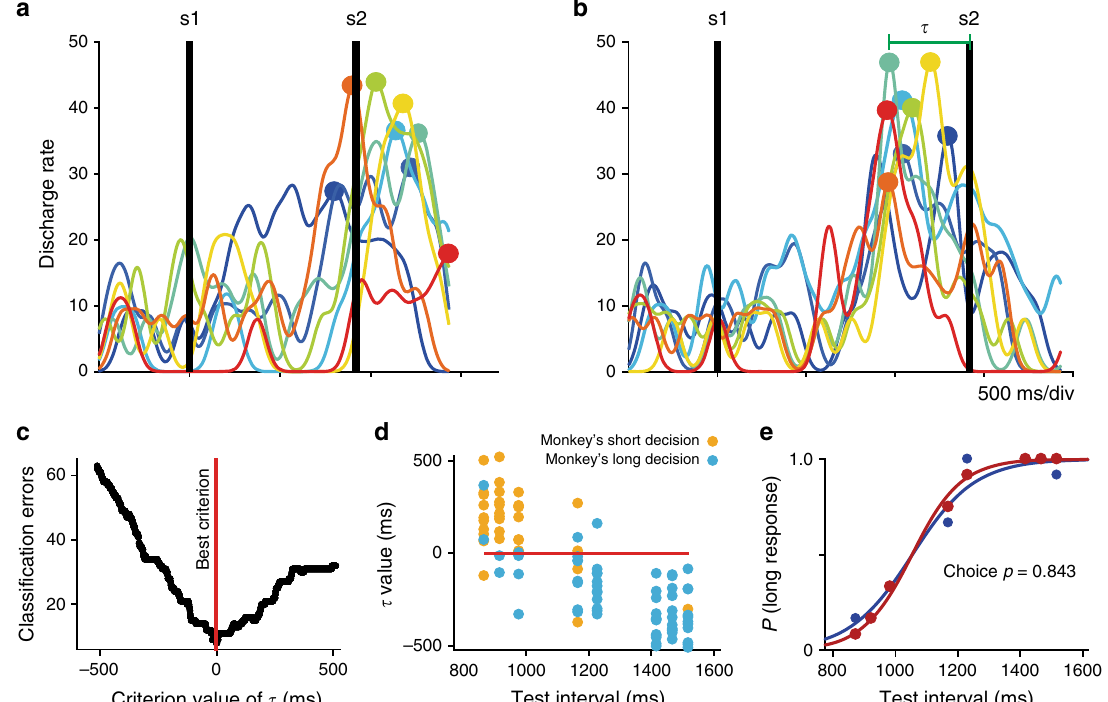
Fig. 4 Trial-by-trial decoding of the monkey ’ s forthcoming perceptual decision employing the peak activity time of boundary neurons. a SDFs of the boundary neuron in Fig. 2a, b for trials in which the shortest test interval (870 ms, block 3) was presented to the monkey. Each color line represents an individual trial (eight trials are shown). Dots indicate the moment of the peak activity. s1 and s2: moments of presentation of the 1st and 2nd stimulus, respectively. Note that most activity peaks occur after the second stimulus. b Trial by trial activity of the same boundary neuron for one of the longer test intervals of the same block (1470 ms, block 3). Note that all activity peaks occur before the second stimulus. The interval between the peak activity ( τ ) and the second stimulus is indicated for one trial. c Number of errors in trial classi fi cation used as categorization cut criteria with a range from − 500 to 500 ms in steps of 1 ms. The best limit criterion corresponds to the value of τ of the boundary neuron in a , b that minimized the classi fi cation error for trials as coming from actual short or long response trials. d Values of τ for the same cell as a function of the test intervals of the block 3 of the time categorization task. Note that for shorter intervals values were mainly positive, which implies that the peak activity occurred mainly after the presentation of the second stimulus. The opposite occurs for longer intervals. The red horizontal line corresponds to the best criterion in c . The color code is in the inset. e Psychometric (blue) and neurometric (red) functions. The neurometric curve was constructed from the trial probability below the best criterion as a function of test interval in d . Logistic functions were fi tted to behavioral and neuronal data; the DLs were 112 ms for both curves and the PSE was 1052 ms for the behavior and 1105 ms for the neurometric function. Finally, the relation between the actual categorical behavior and the neural classi fi cation of the cell activity in c for the 96 trials was remarkably large ( χ 2 -test = 63.8, P < 0.00001), as well as the mean boundary-choice probability (Methods